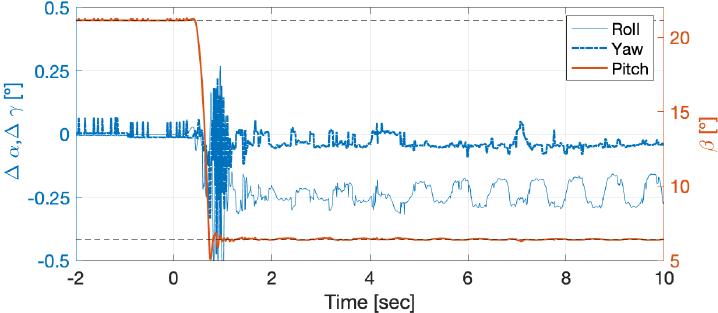
Figure 6. Measured angles of the rigid body caused by the sudden removal of the support